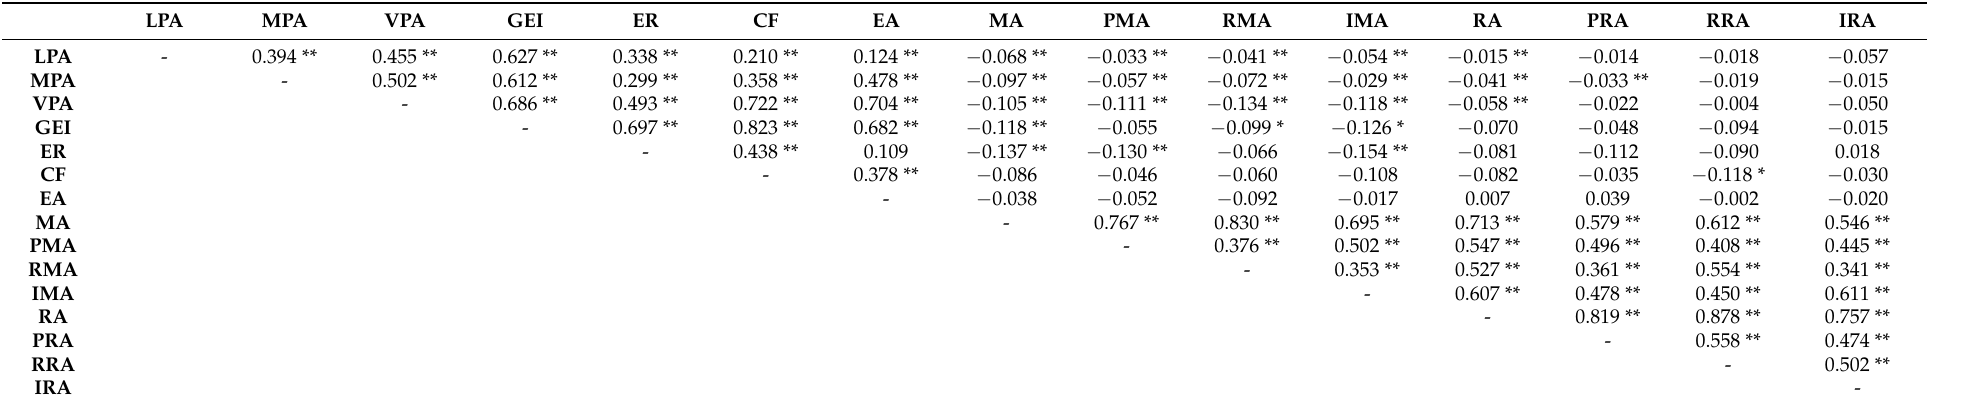
Table 2. Bivariate correlations between PA, EI, and aggressive behaviours for women.